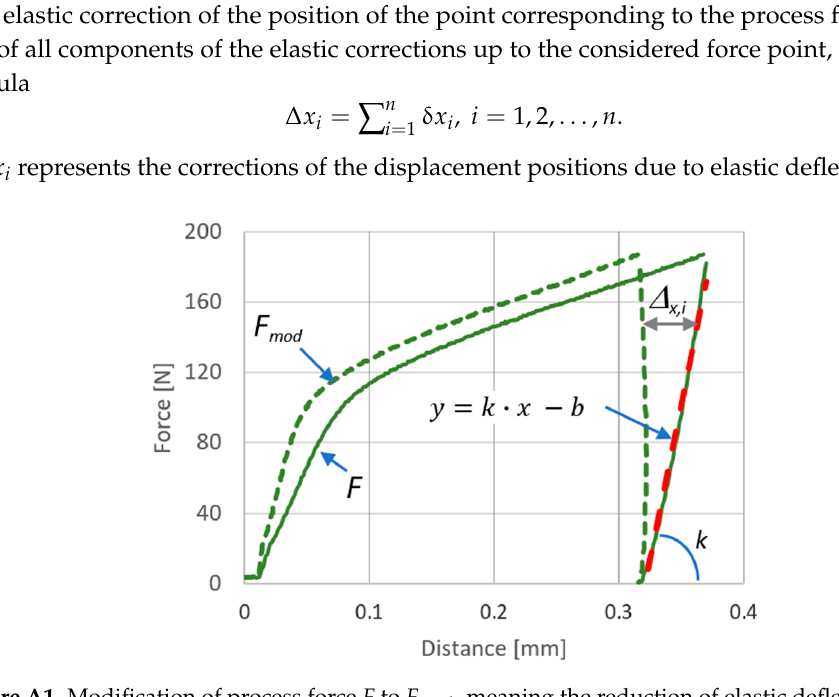
Figure A1. Modification of process force F to F mod , meaning the reduction of elastic deflection of the load system.